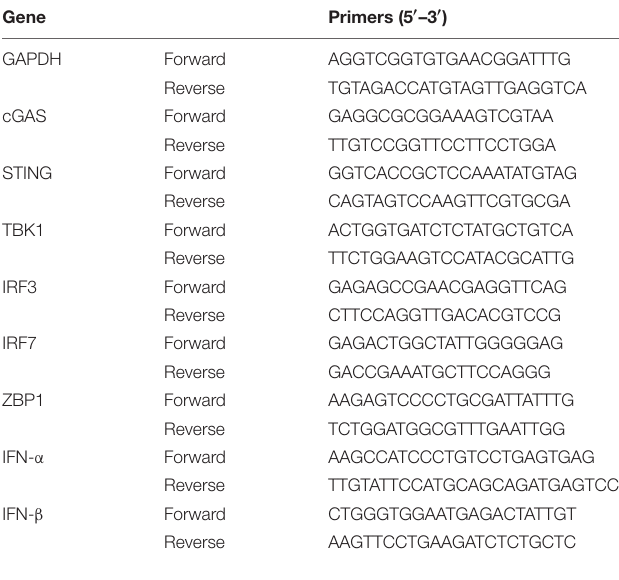
TABLE 1 | The two additional gene sets used for enrichment analysis.